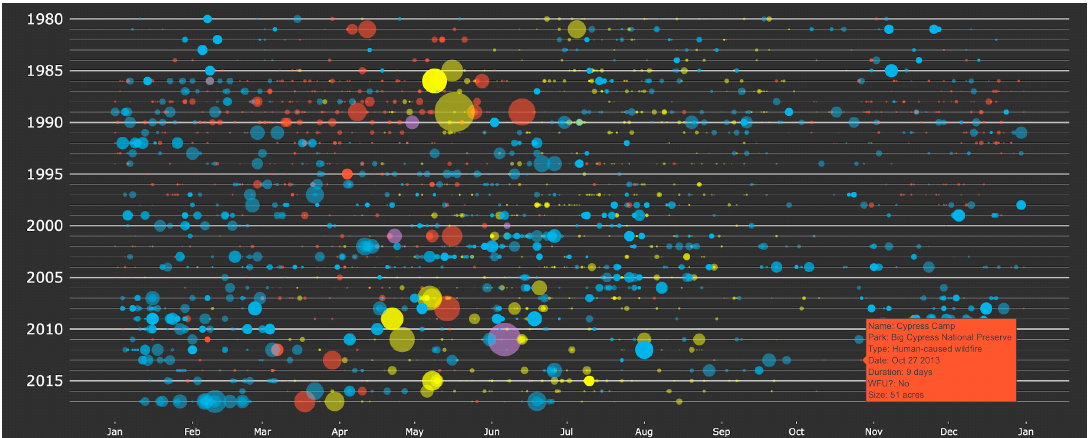
Figure 3. The fire history chart is at the center of the visualization dashboard. This chart represents the seasonal variability in natural (yellow), human-caused (red), prescribed (blue), and mutual aid (purple) fire regimes. When users hover over a specific fire, pop-up boxes (e.g., in red) display detailed information about selected individual fires.